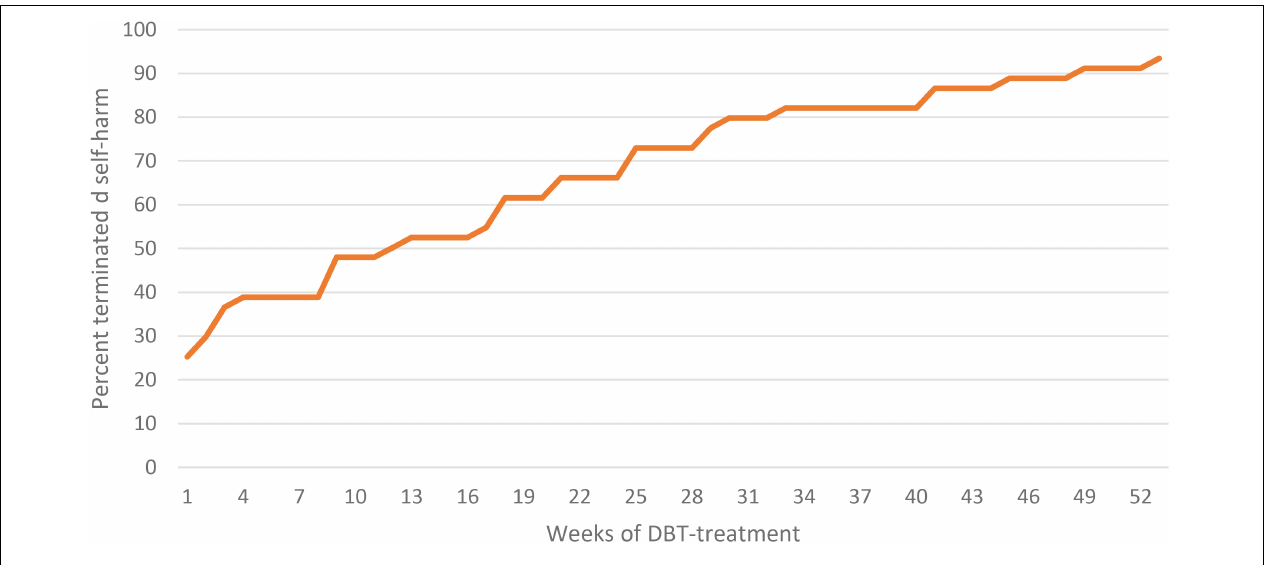
FIGURE 2 | Cumulative percentage of patients that terminated self-harm behavior in the treatment period. TABLE 1 | Baseline demographics and clinical characteristics for patients ending the self-harm early (before 8 weeks) and late (after 8